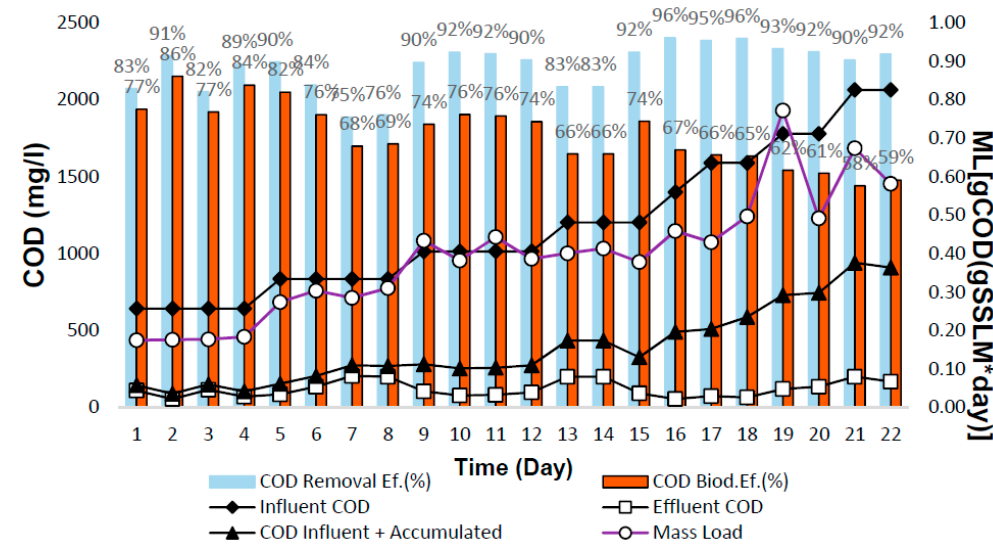
Figure 5. Graphic of the evolution of the removal and biodegradation of COD in the mass load.